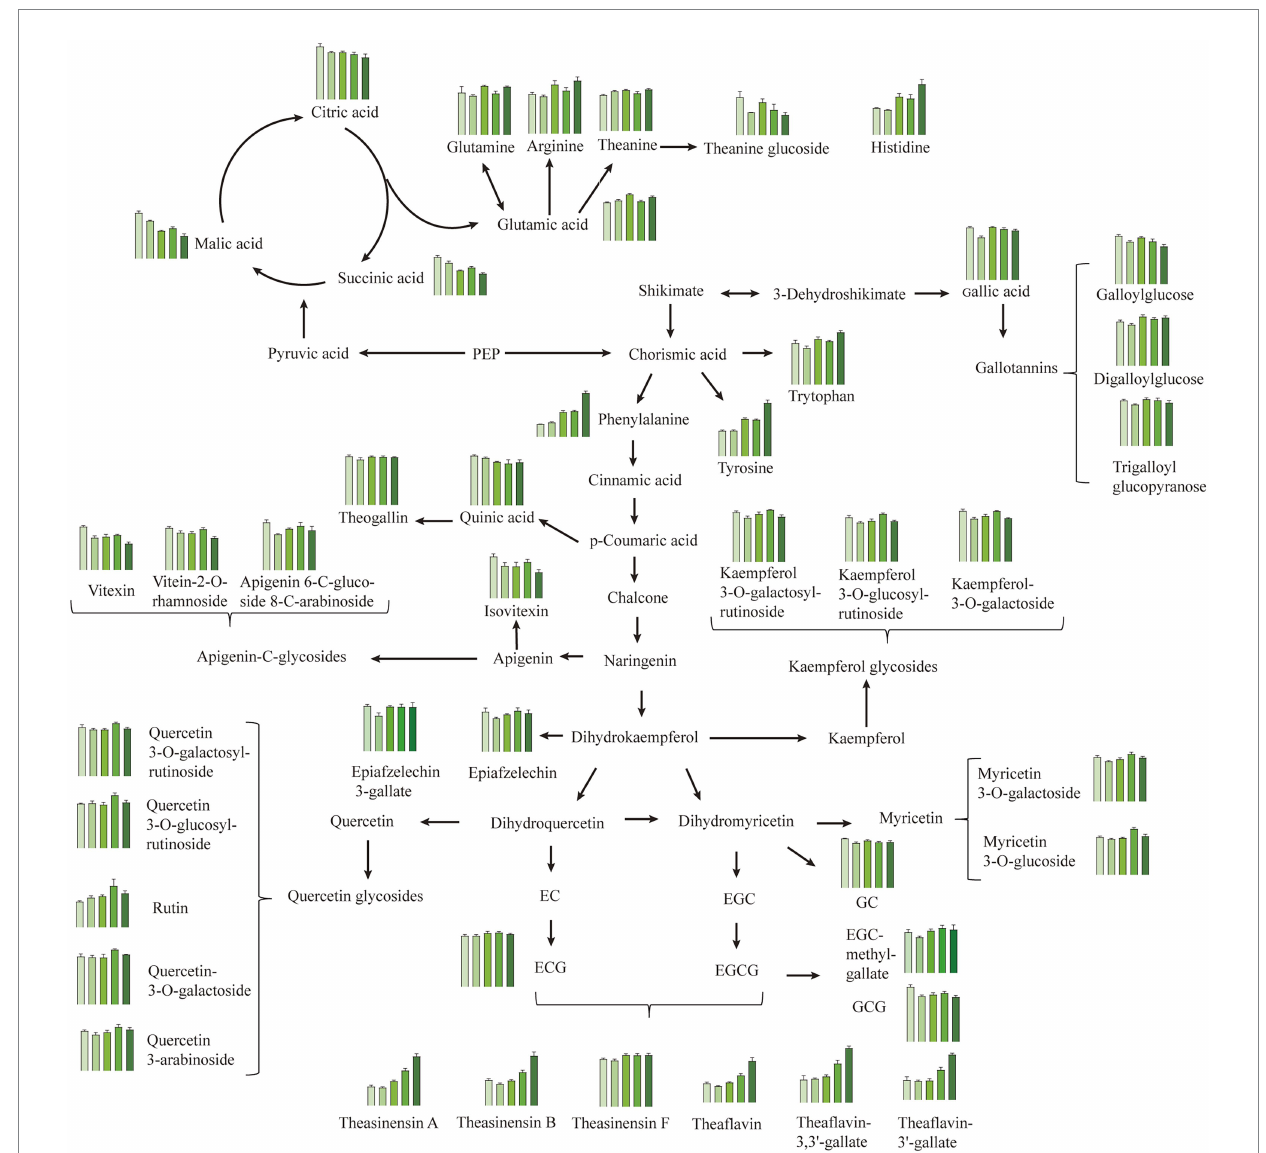
FIGURE 5 Metabolism pathways of the main metabolites in Longjing tea with different withering degrees, including phenolics, organic acids, and amino acids. The bar plots show the metabolite contents in W1, W2, W3, W4, and W5 from left to right. Data is displayed as mean ± SD using relative abundance which was calculated by normalizing to the total ion intensity. All metabolites shown in the bar plot were significantly differential (one-way ANOVA with LSD post hoc test, p < 0.05). PEP,